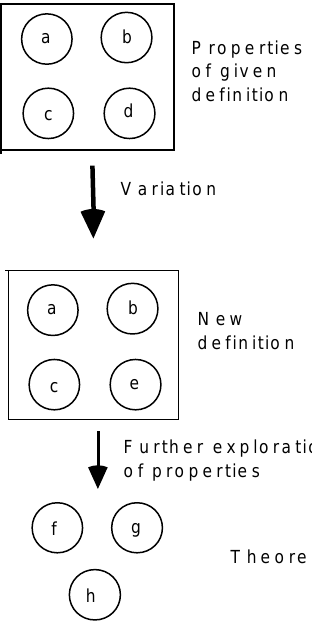
Figure 1: Constructive Defining